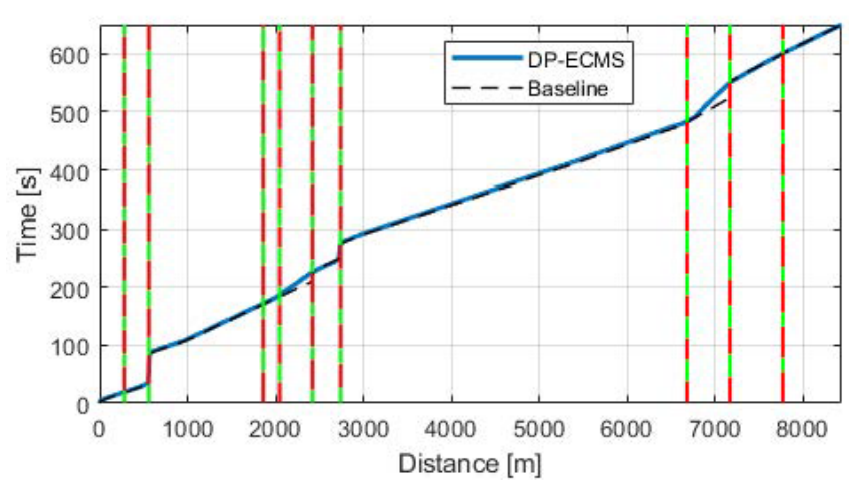
Figure 9. Time vs. distance for DP-ECMS and